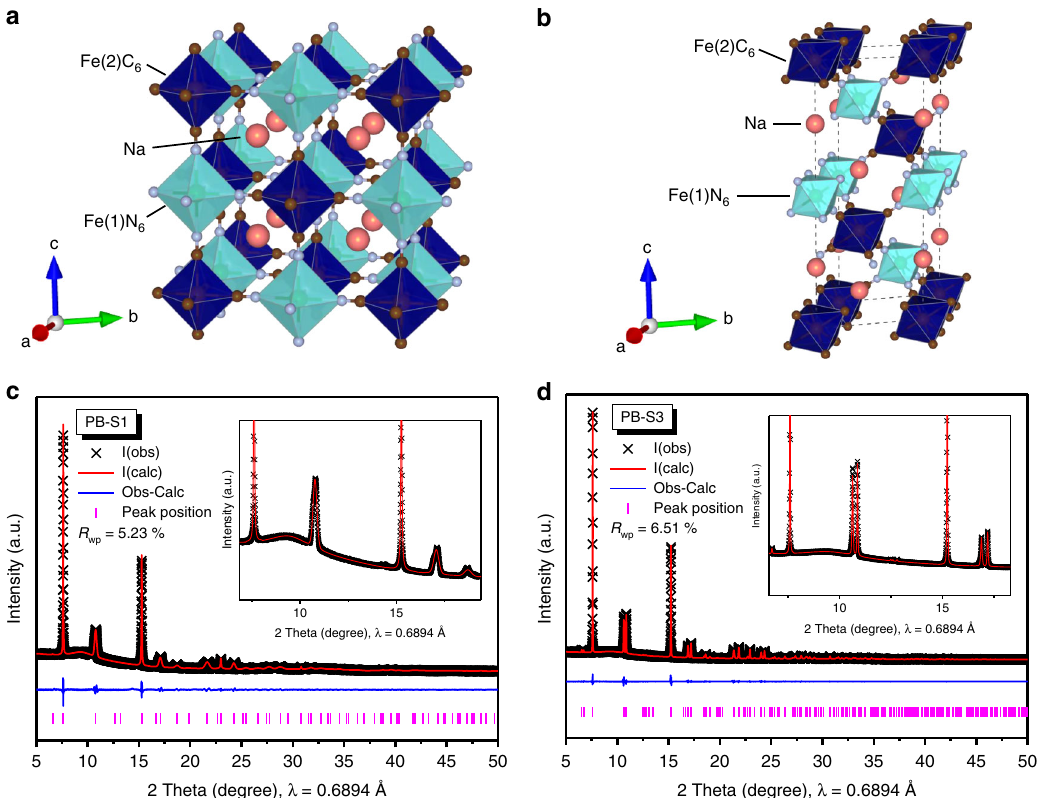
Fig. 1 Structure and Rietveld re fi nement of cubic and rhombohedral samples. a , b Schematic structure (Na in red, C in brown, N in grey, Fe1 and Fe2 in cyan and blue, respectively) and ( c , d ) Rietveld re fi nement synchrotron PXRD pattern of cubic PB-S1 and rhombohedral PB-S3 sample, respectively.